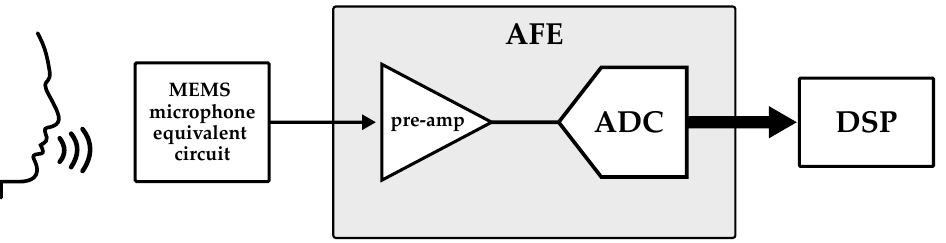
Figure 12. Block diagram of the readout chain of a MEMS